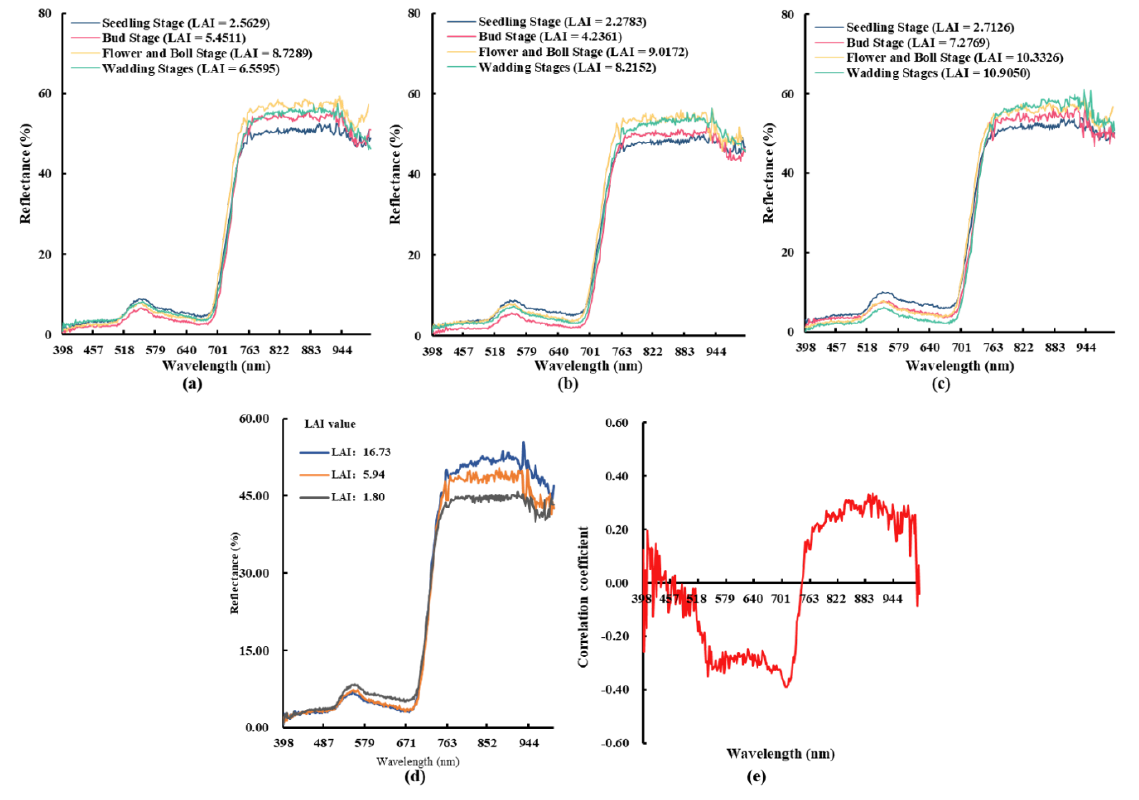
Figure 2. ( a ) Xinluzao 53 leaf area index and spectral difference of cultivars at different growth stages, ( b ) Xinluzao 45 leaf area index and spectral difference of cultivars at different growth stages, ( c ) Luyanmian 24 leaf area index and spectral difference of cultivars at different growth stages, ( d ) cotton canopy reflectance and ( e ) correlation analysis of cotton LAI index.